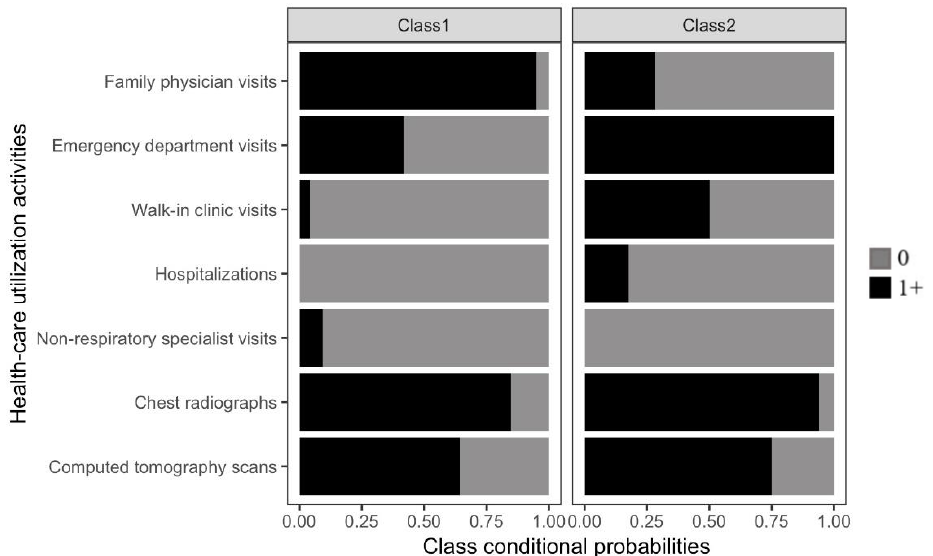
Figure 5. Class-conditional probabilities for the final two-class model from the latent class analysis.